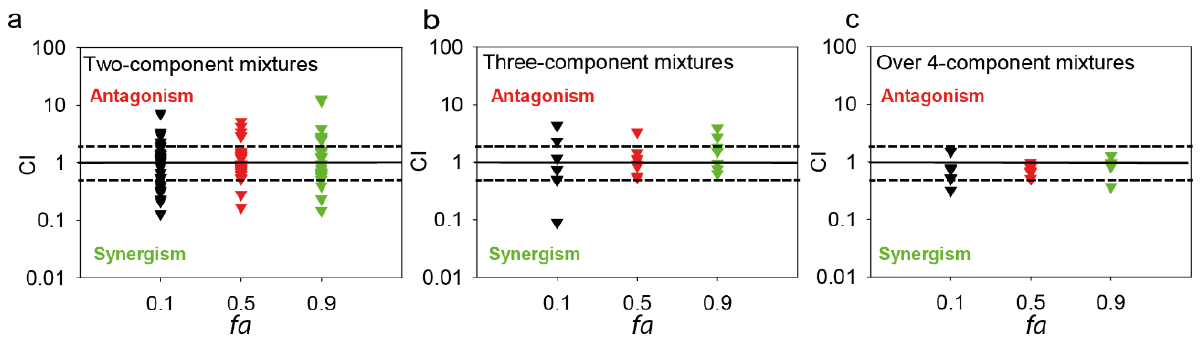
Figure 4. CI values of two-component mixtures ( n = 63) ( a ); three-component mixtures ( n = 21) ( b ) over four-component mixtures ( n = 18), ( c ) at three representative effect levels fa (0.1, 0.5, 0.9 ) for a variety of pollutant combinations, such as heavy metals,